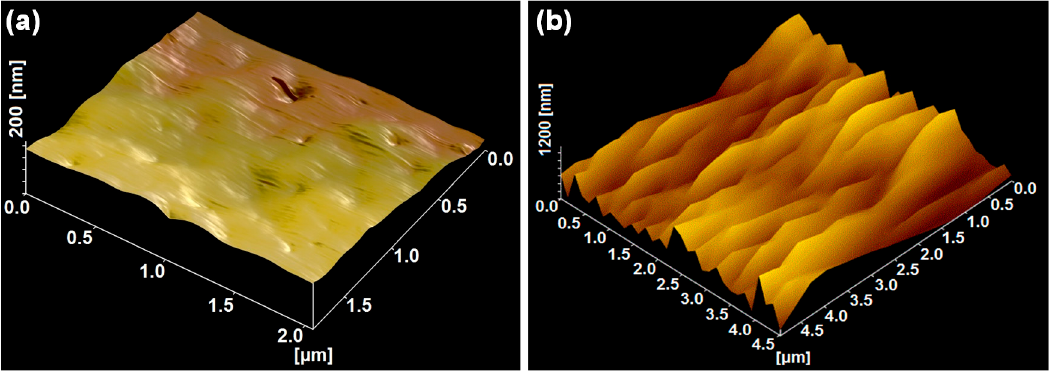
Figure 4. Three ‐ dimensional atomic force microscopy (AFM) photographs of the surface layer of ( a ) PZ ‐ 0 and ( b ) PZ ‐ 17.